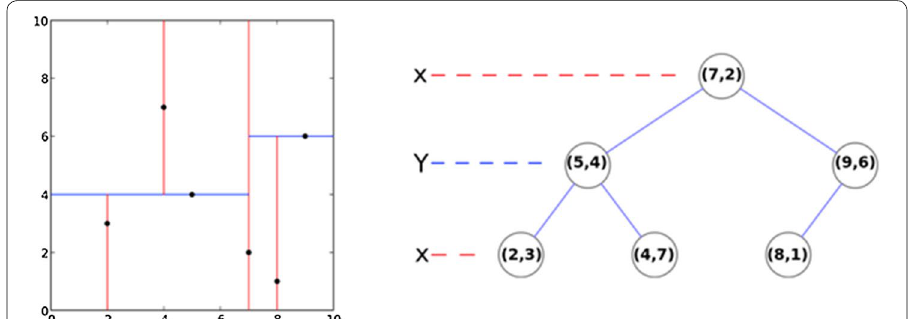
Fig. 5 Illustration of kd-tree algorithm for finding nearest neighbour in 2-dimentional